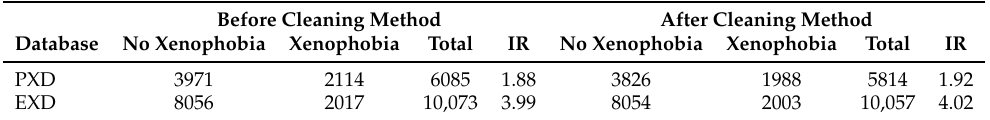
Table 7. Comparison between the number of tweets belonging to the non-xenophobic and xenophobic classes before and after using the cleaning method. The class imbalance ratio (IR) is calculated as the proportion between the number of objects belonging to the majority class and the number of objects belonging to the minority class [36]. The higher the IR value, the more imbalanced the database is.